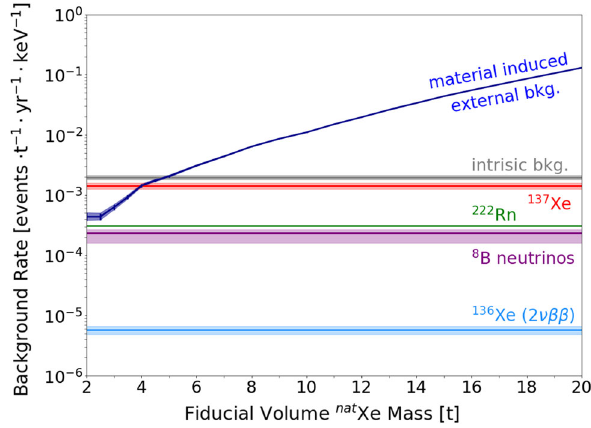
Fig. 6 Background rate in the ROI versus fiducial mass. External con- tributions are combined. Fiducial volume independent intrinsic sources are shown per contribution. Bands indicate ± 1 σ uncertainties. At 5t, the external sources contribute at the same level as the combined intrin- sic